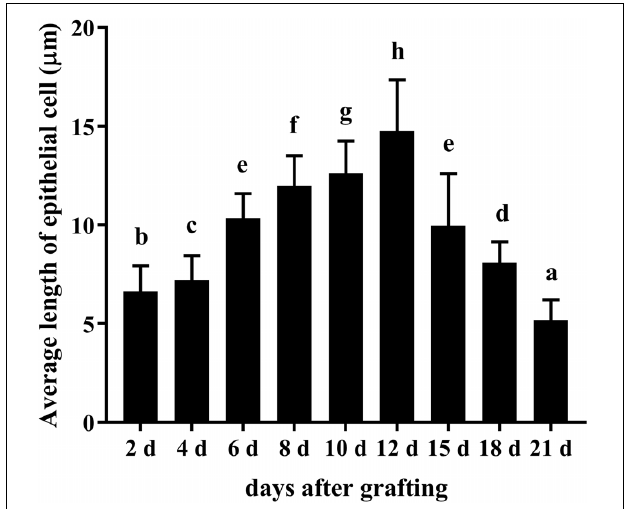
FIGURE 5 | Changes in average length of epithelial cell of saibo and pearl sac during the pearl sac formation. Each bar represents mean ± SD. Means with different superscript letters are significantly different at P < 0.01 by the Tukey’s HSD test.